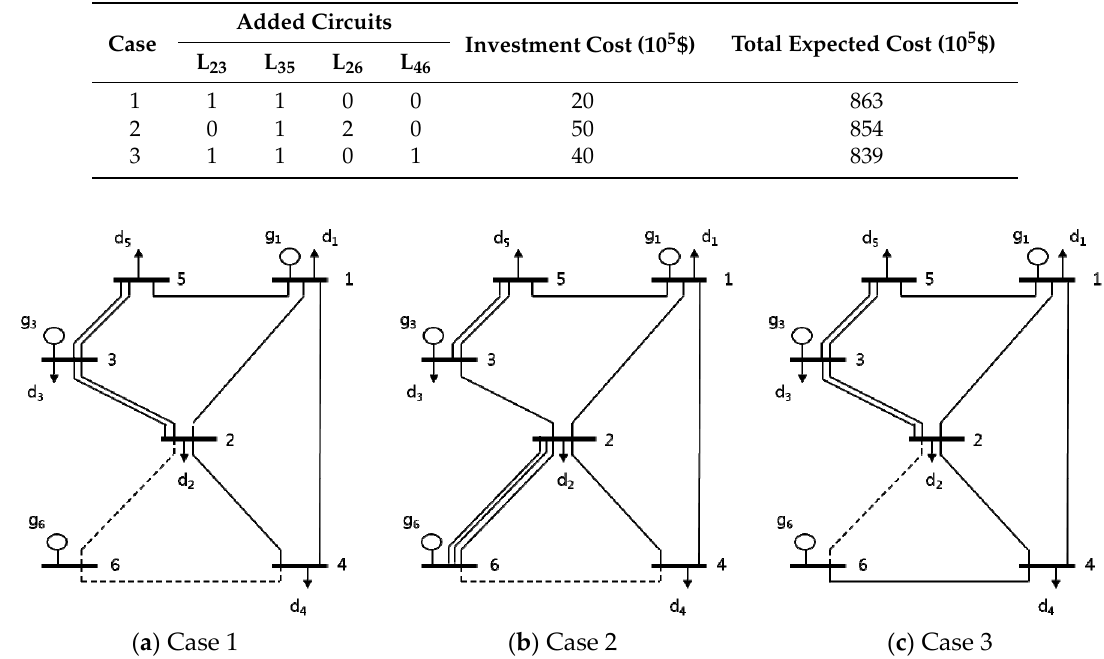
Table 3. Results for different approaches.